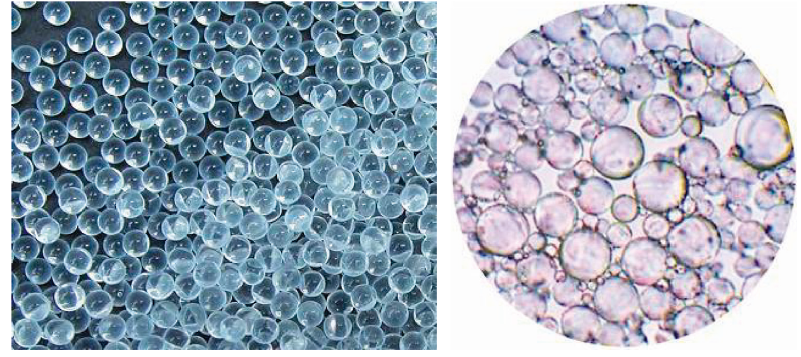
Figure 5: Microscopic topography of HGB. Table 1: Chemical composition of HGB.